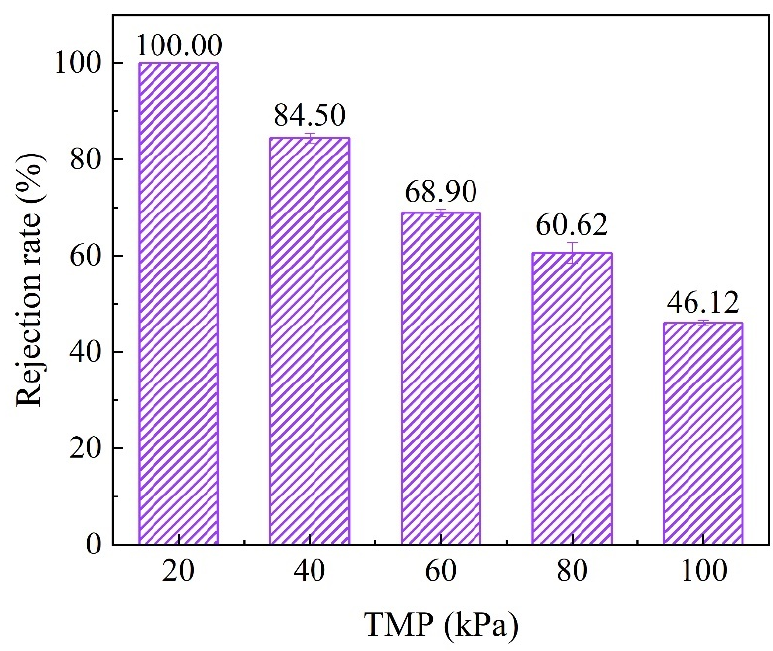
Figure 2. The rejection efficiency of BSA by the membrane. Conditions: [BSA] 0 = 100 mg L − 1 . Membrane fabrication: s/c = 0.5, 20 °C, 90% RH, curing for 14 d.